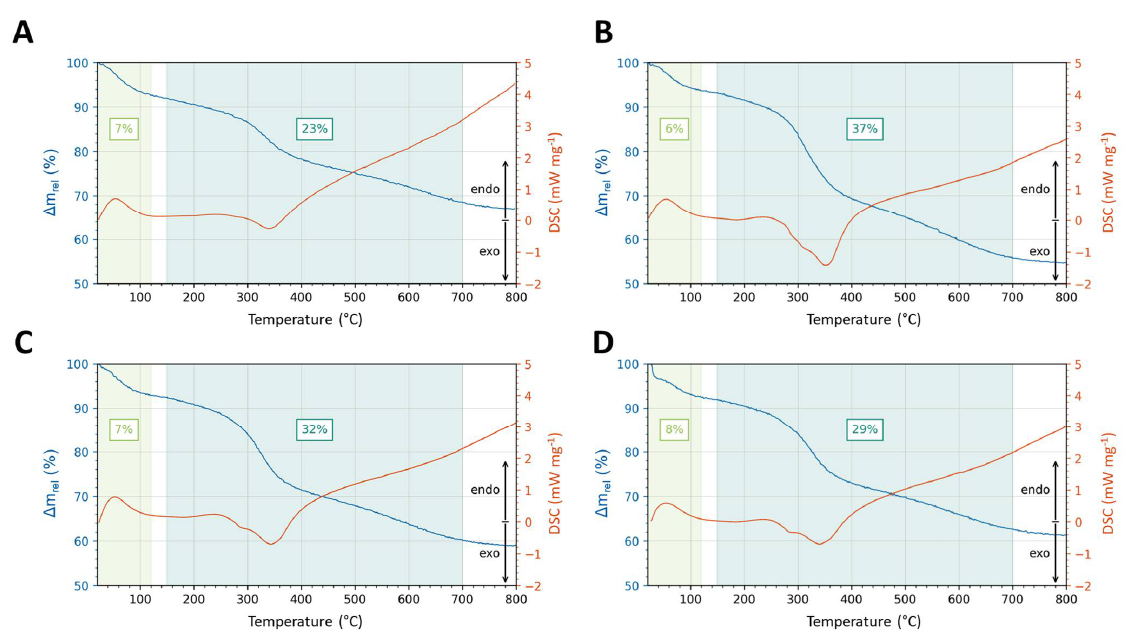
Figure 6. Thermogravimetric and differential thermal analysis of CysR5 1′ ( A ), RRIL-1 2′ ( B ), RRIL-2 3′ ( C ), and RRLL 4′ ( D ) silica particles. To gain insights about the porosity of the of CysR5, RRIL-1 and RRIL-2 silica-based particles before and after calcination, nitrogen physisorption analysis at -196 °C was per- formed. The physisorption isotherms of CysR5 1′ (blue), RRIL-1 2′ (orange) and RRIL-2 3′ (green) silica particles are shown in Figure 7 before (A) and after (B) calcination. The phys- icochemical parameters derived from gas adsorption are compiled in Table 3. Before cal- cination, the samples show low porosity as reflected by isotherm curves indicating mostly non-porous materials. One can notice an increase in the adsorption volume at high relative pressure, which could be attributed to external surface area originating from some in- terparticle pores/voids, which is typical for colloidal silica materials [70,71]. Only sample RRIL-1 2′ shows a non-negligible (internal) porosity before calcination, with a slightly in- creased adsorbed volume at low pressure (leading to a modest surface area of 48 m 2 /g), the origin of which remains unclear at the moment.